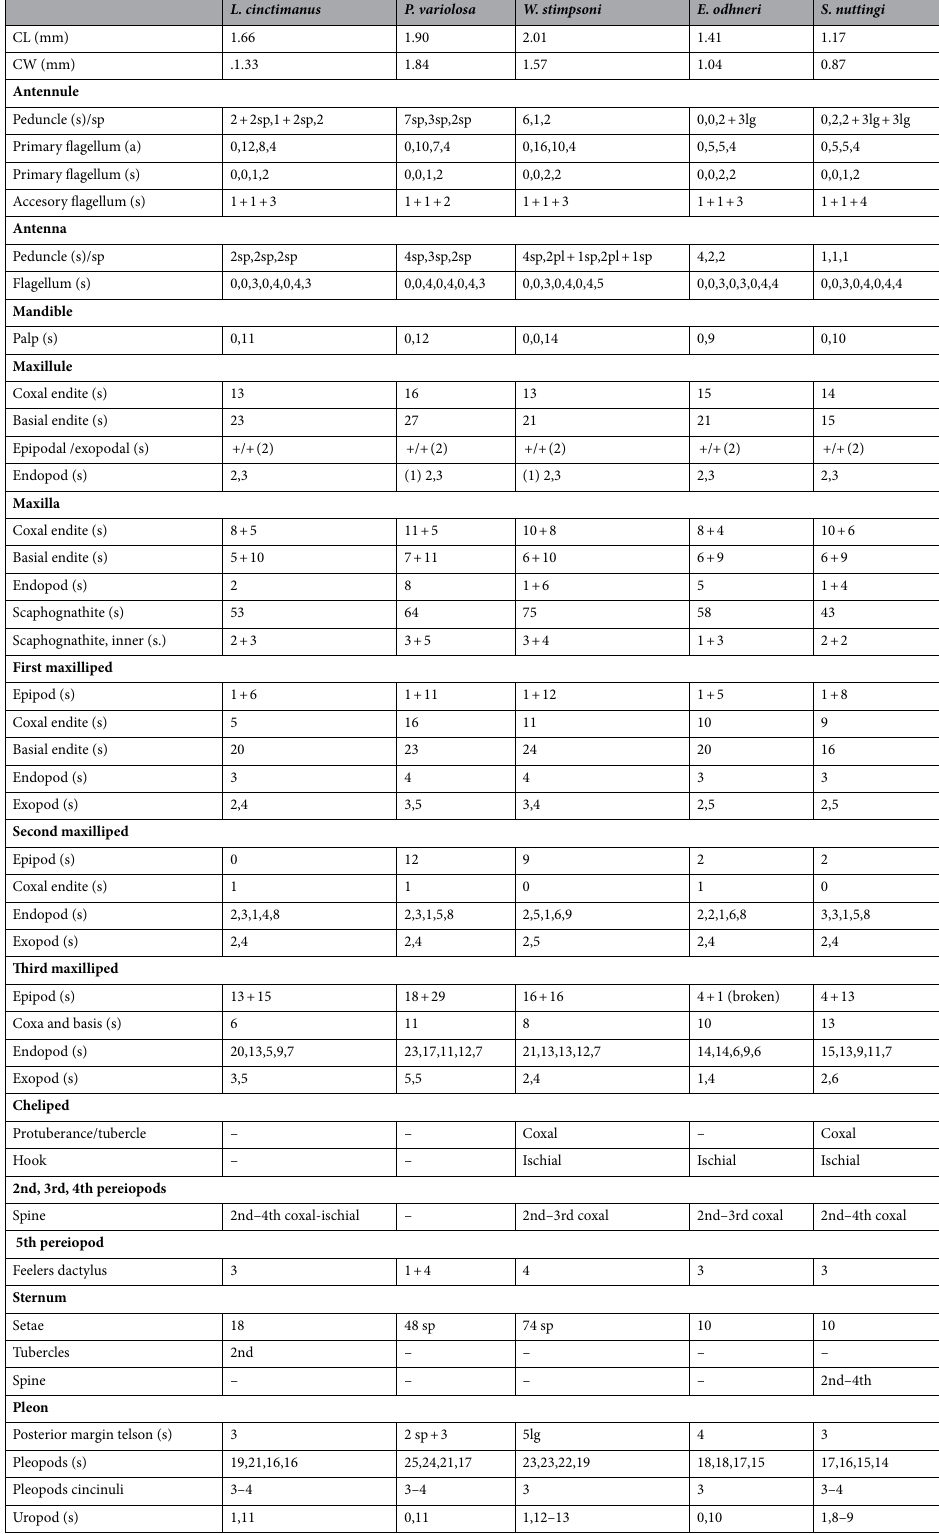
Table 3. Meristic and morphological characters of the megalopa stage of 4 species of Xanthidae: Liomera cinctimanus, Pseudoliomera variolosa, Williamstimpsoni stimpsoni, Etisus odhneri, and 1 species of Pseudorhombilidae: Scopolius nuttingi . a aesthetacs, lg long, pl plumose, s setation, sp spine, + present, –